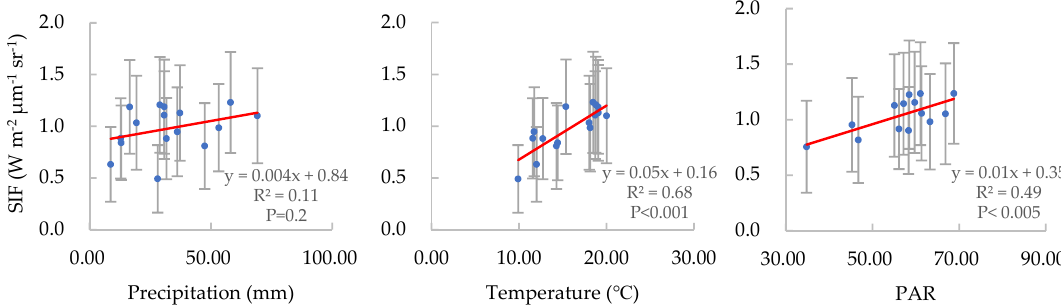
Figure 7. Scatter plot between SIF and precipitation (left), temperature (middle), and PAR (right) over the course of 16 days.